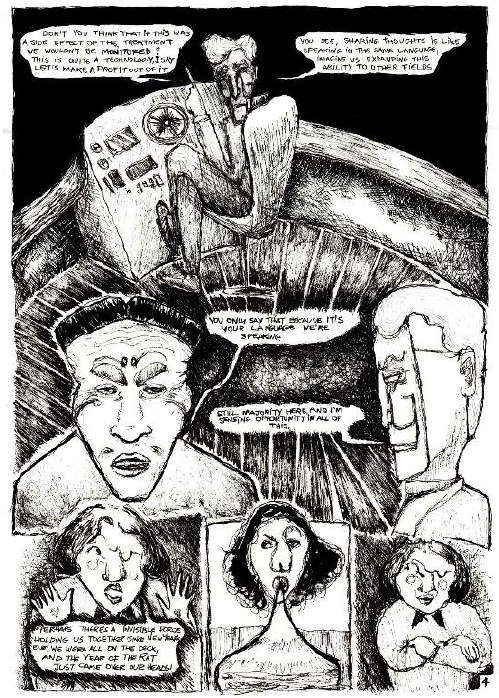
Figure 5: Plate 4, Diamond Princess